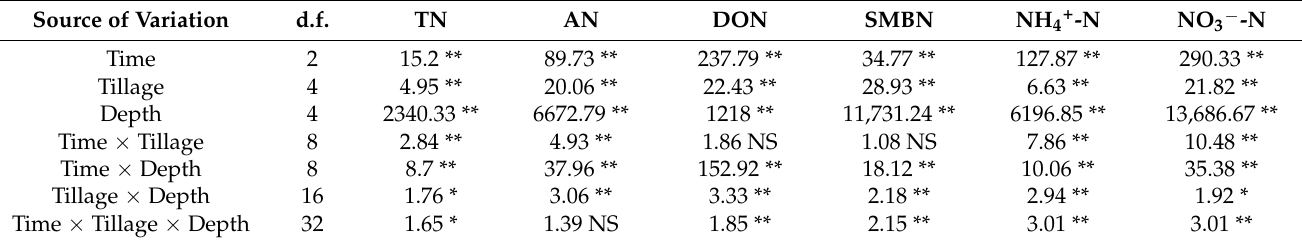
Table 1. The three-factor analysis with time, tillage, and soil depth on different nitrogen